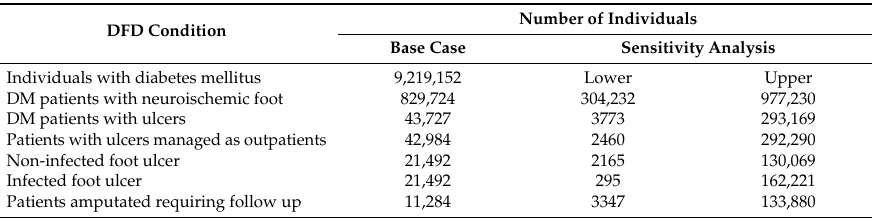
Table 3. Estimated number of diabetics and outpatients with diabetic foot diseases. Base-case and sensitivity analysis. Brazil, 2014.